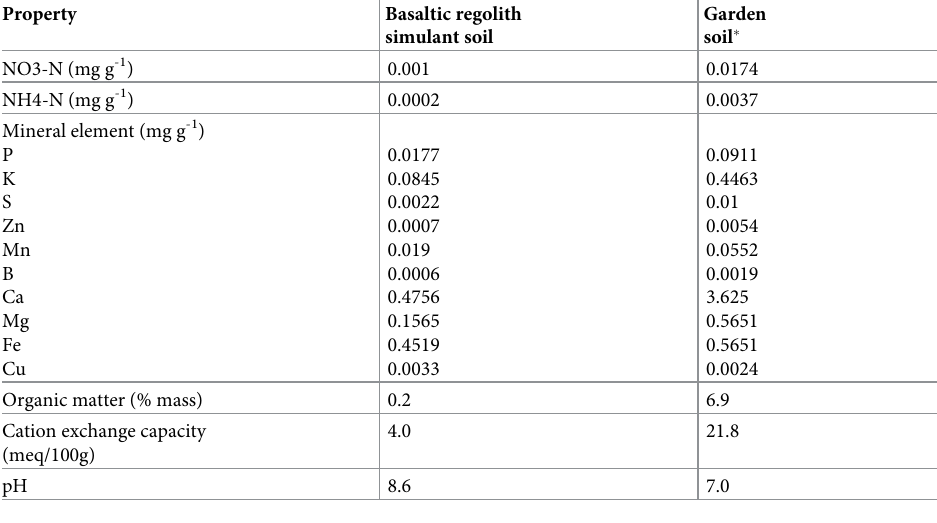
Table 1. Properties of basaltic regolith simulant